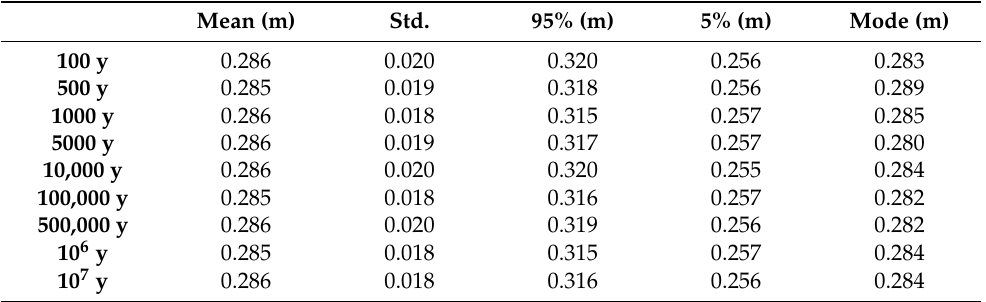
Table 13. Probabilistic flood hazard analysis results for the control building of NPP 3 (elevation 80 ft).